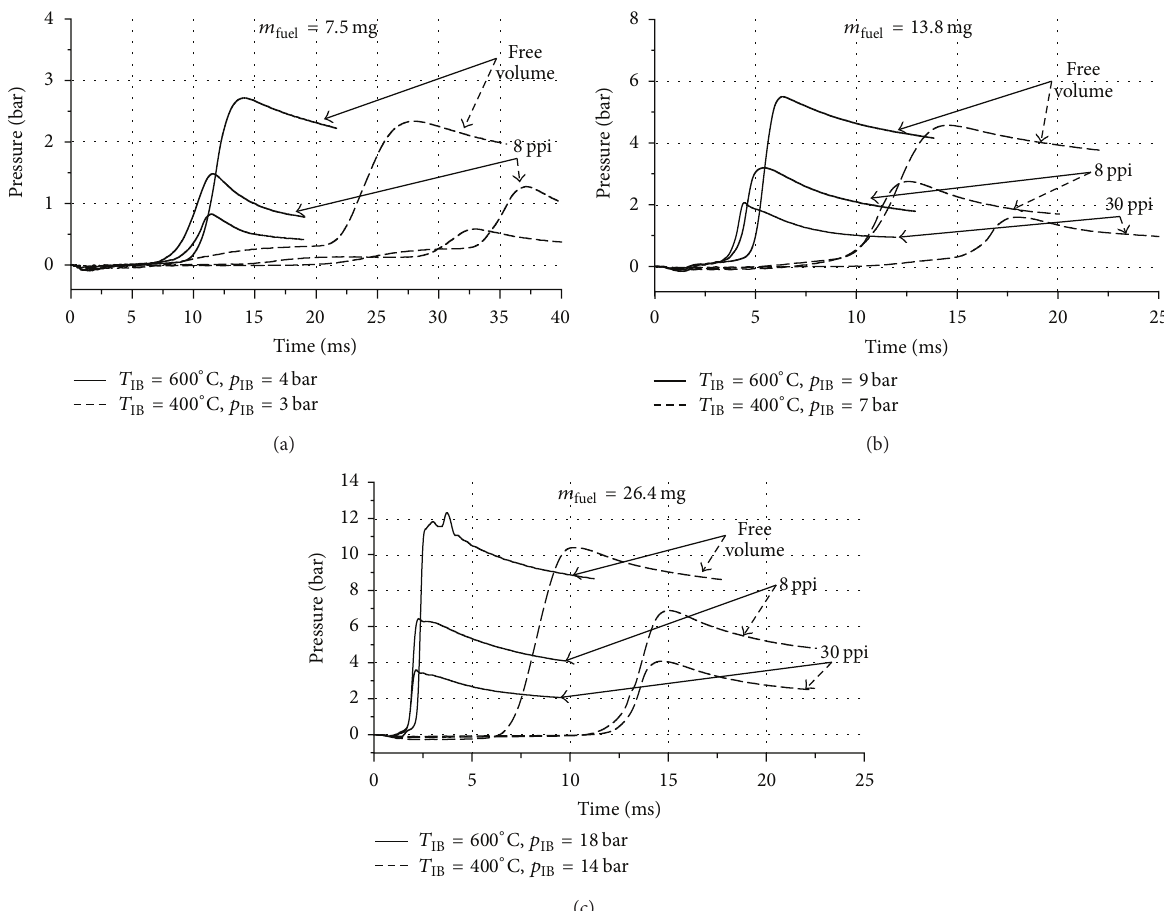
Figure 12: Comparison of pressure histories for heat release in different SiC foam porous reactors and in free volume combustion chamber after fuel injection starts for different mass of injected fuel at different initial pressure for two initial reactor temperatures (400 ∘ C—dashed line; 600 ∘ C—solid